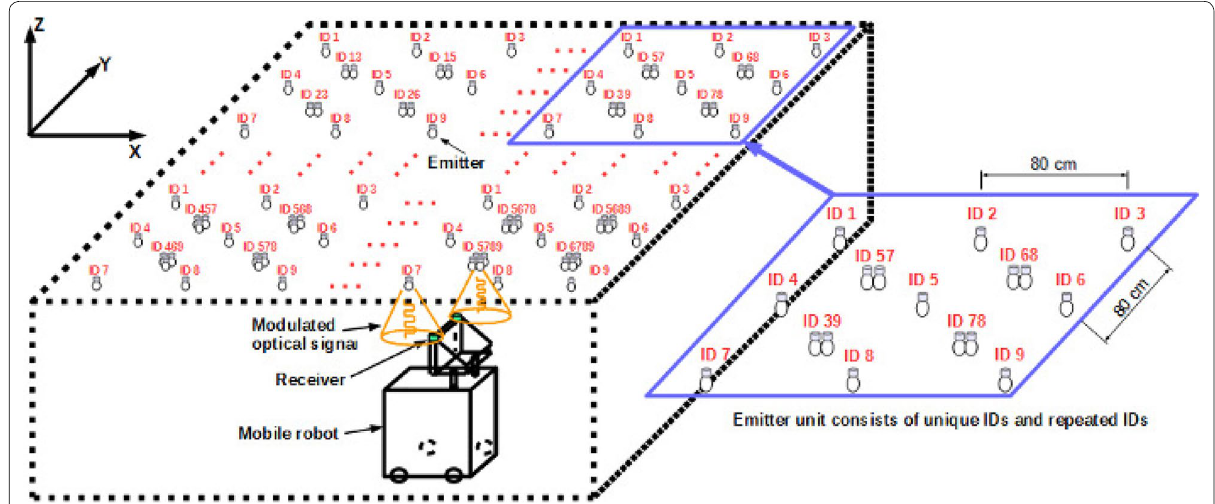
Fig. 1 Illustration of the proposed IR LED-based localization